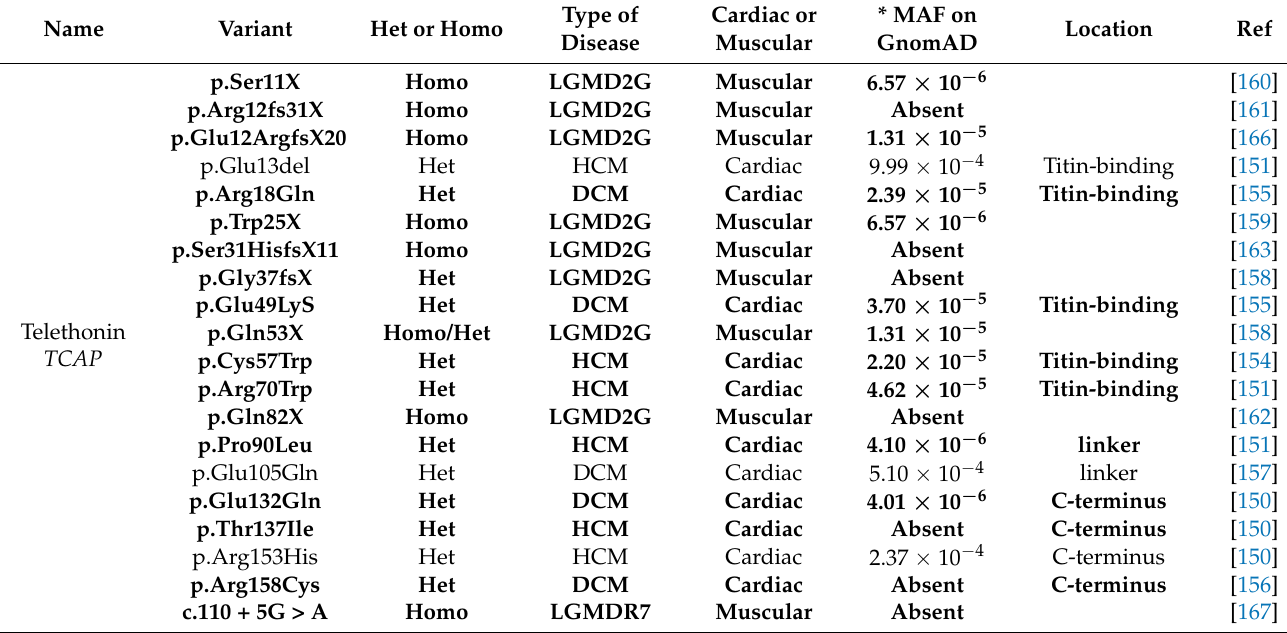
Table 5. Variants in the TCAP gene that have been previously reported in individuals with myopathy or